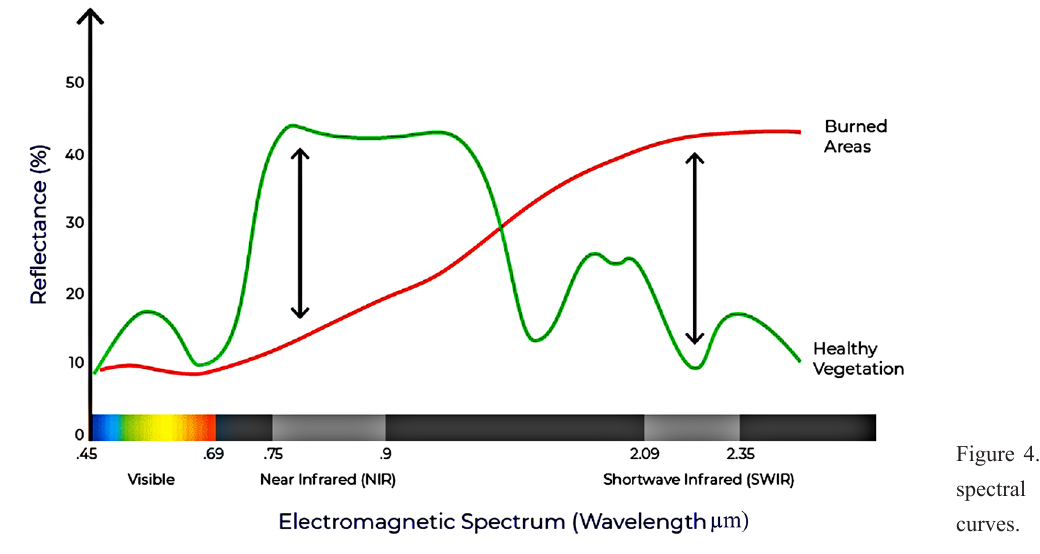
Figure 4. Exploiting spectral response